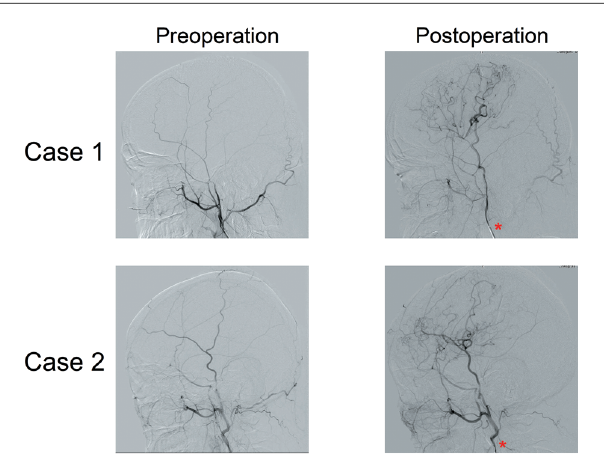
FIGURE 2 Representative images of DSA before and after surgery. At 6 months after surgery, the symptomatic hemispheres were found to have a functioning extra-intracranial bypass. The speci fi c contrast agent injection site (external carotid artery) is indicated by a red